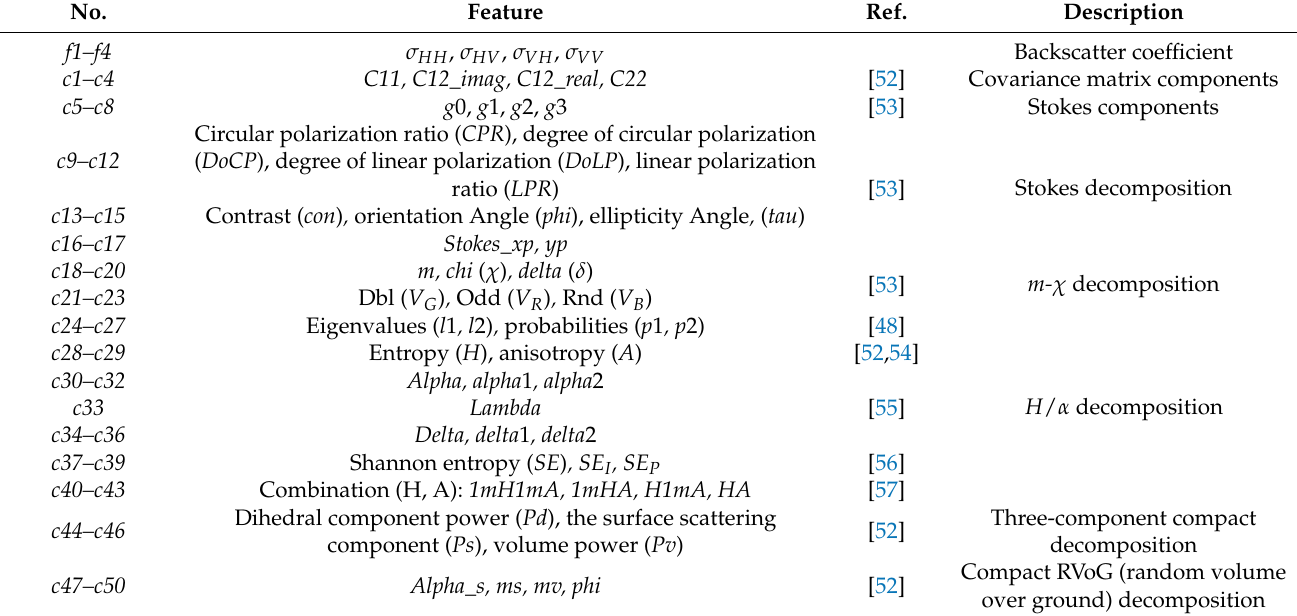
Table 2. Polarimetric features used in this